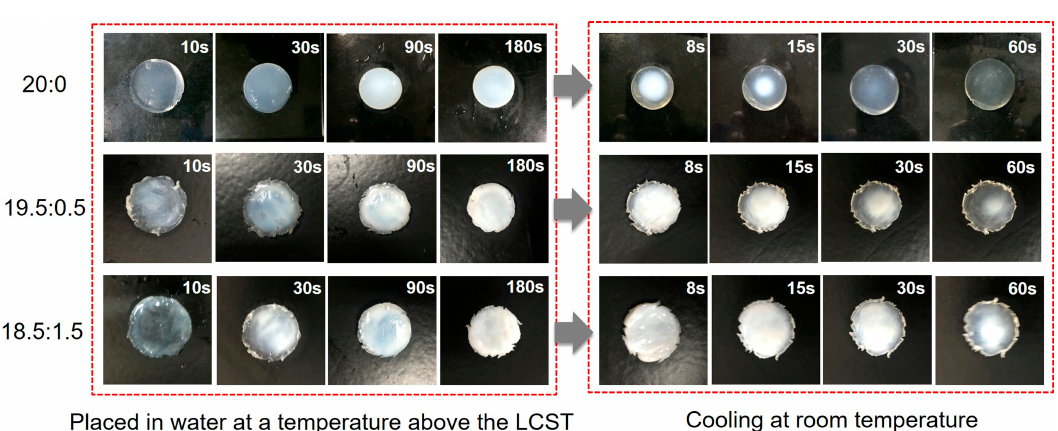
Figure 8. Digital photographs of hydrogels with the change of temperature (the observation time is presented in the upper right of each figure).